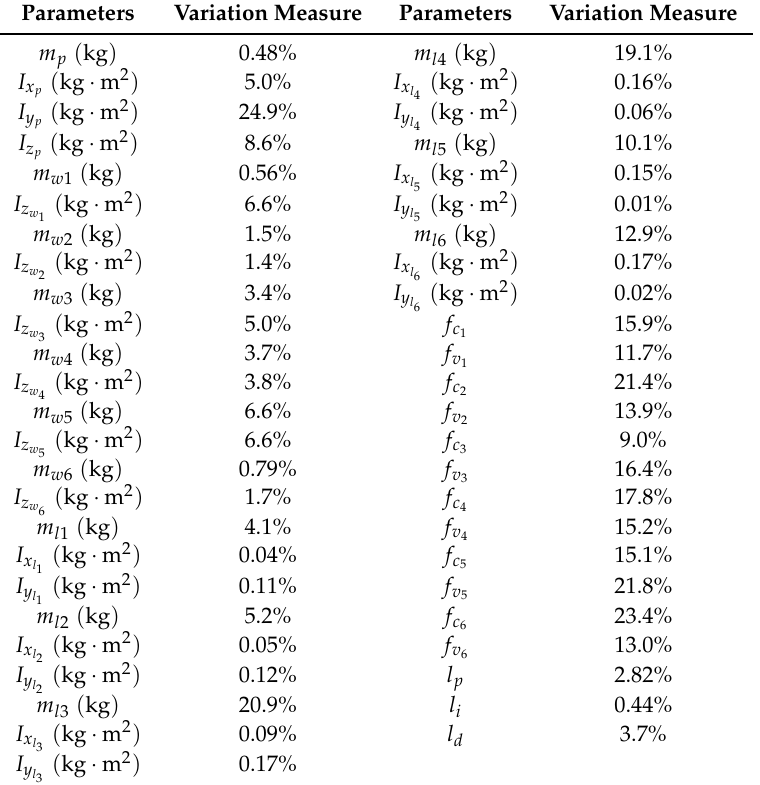
Table 5. Variation measure of the identification